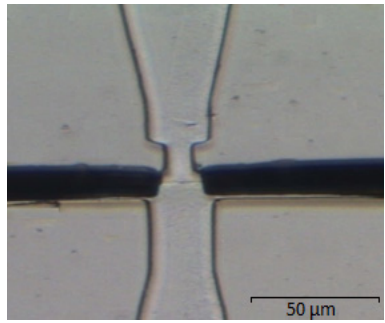
Figure 5. Image of the sensing area of the device.